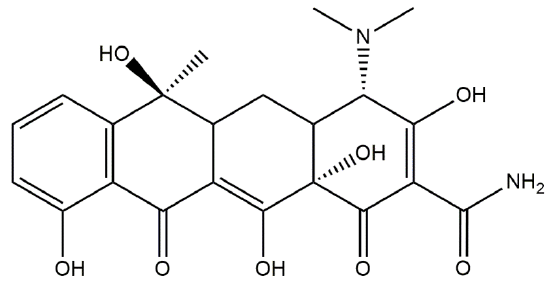
Figure 7. Schematic representation of tetracycline’s chemical structure.